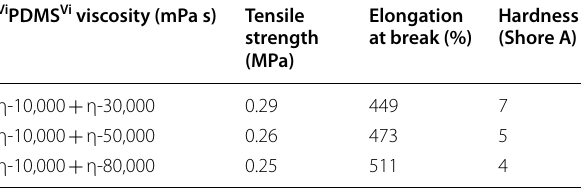
Table 5 Effect of molar ratio of vinyl groups to active hydrogen on mechanical properties of PDMS polymer